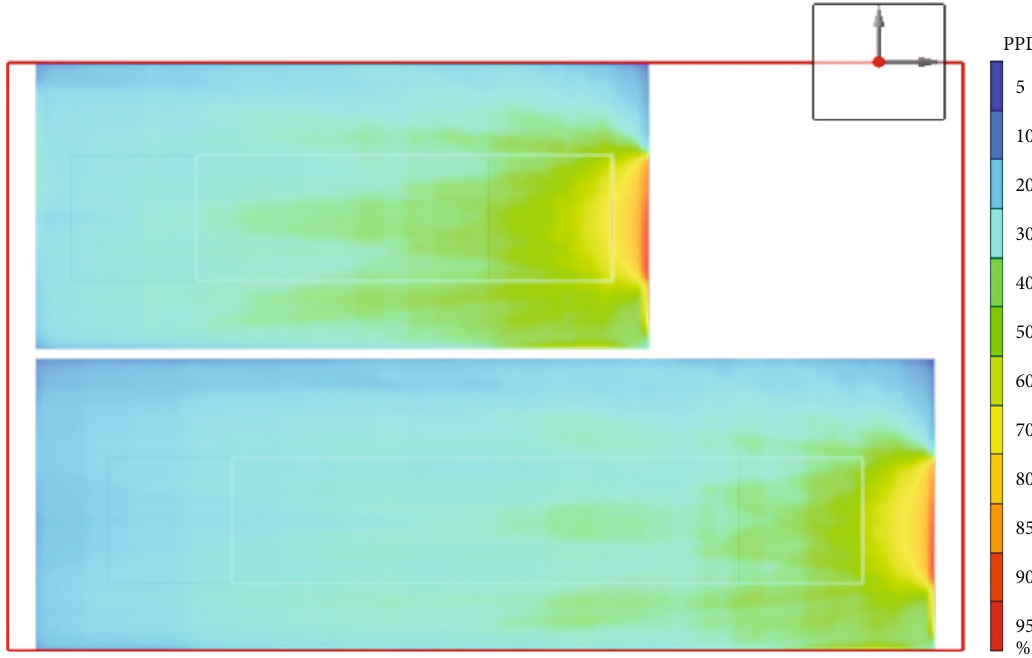
Figure 17: The thermal predicted percentage of dissatis fi ed residents of the studied building (side view).